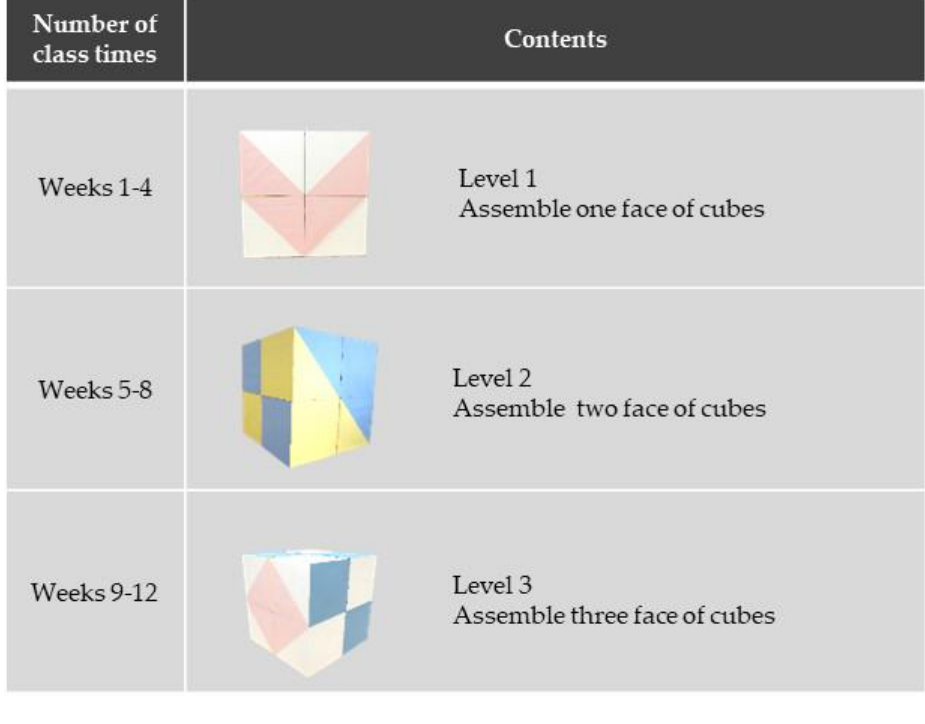
Figure 1. The contents of the cube exercise.